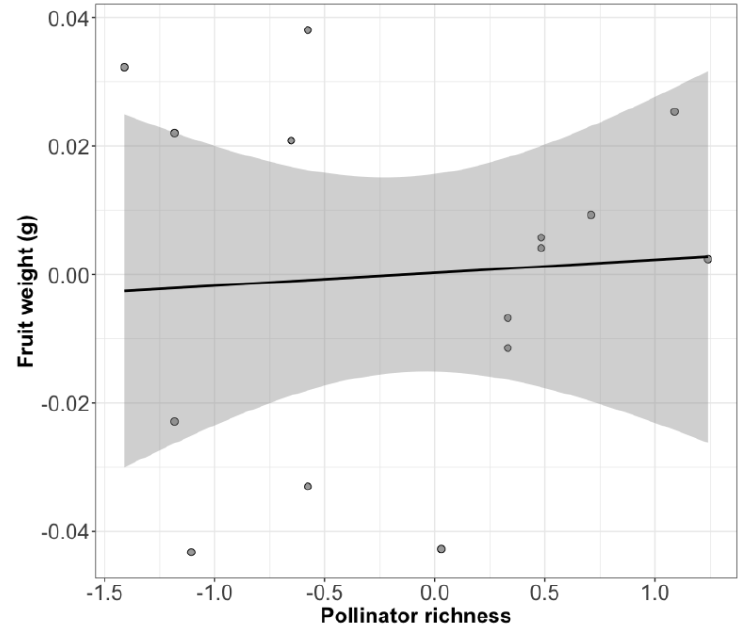
Figure S7. Partial residual plots showing the effect of pollinator richness on site-level average fruit weight. Here, a site with a particularly large pollinator richness value is removed to test whether it might be driving the significant relationship. Dots represent values for each site (N=15